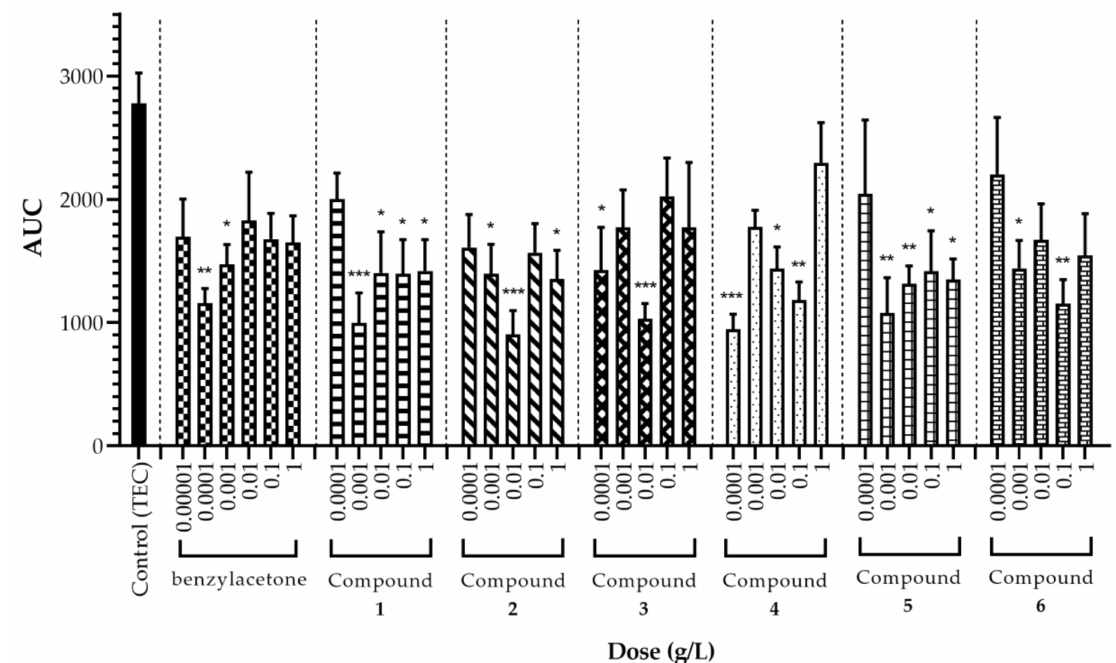
Figure 2. Total spontaneous motor activity of mice treated with the compounds shown in Figure 1. Data are expressed as mean ± SEM ( n = 6). Statistical differences vs. control group were calculated using One-way ANOVA followed by Dunnett’s test. (* p < 0.05; ** p < 0.01; *** p <